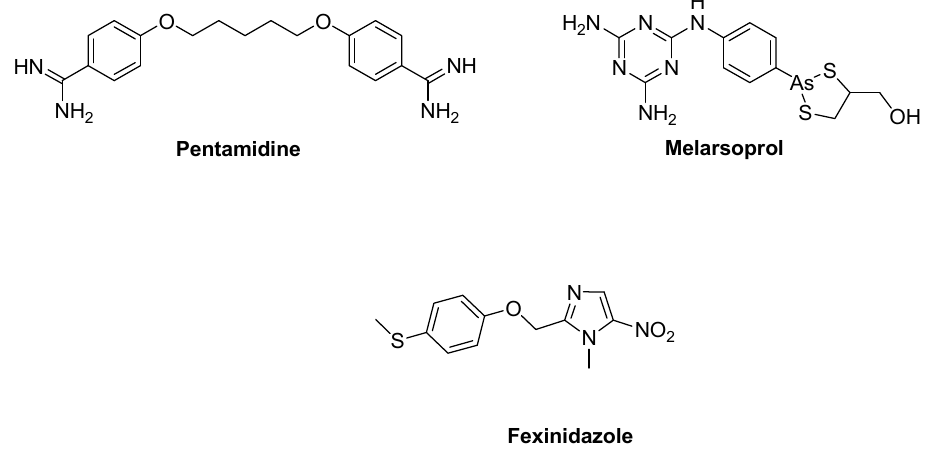
Figure 1. Examples of some drugs used for the treatment of human African sleeping sickness.